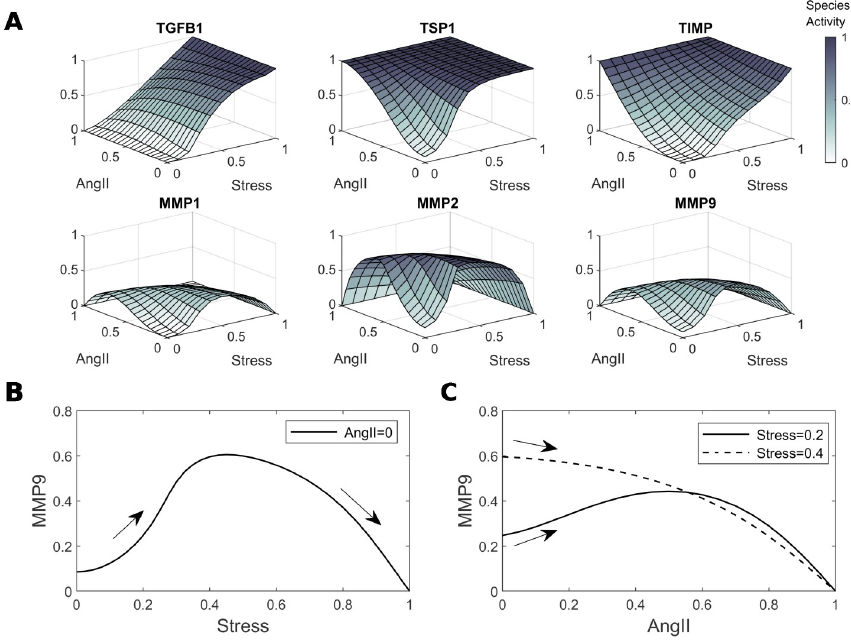
Fig 5. Model dose-response surfaces to Stress and AngII and consequences of non-monotonicity. A. Output steady states of 6 species of interest as a function of Stress and AngII inputs, yielding dose-response surfaces. B. Cross-section of the MMP9 surface showing how MMP activity can first increase and then decrease in response to Stress, here with AngII = 0. C. Cross-section of the MMP9 surface showing that intermediate and high baseline Stress can lead to either initial increases or decreases in MMP activity as AngII is